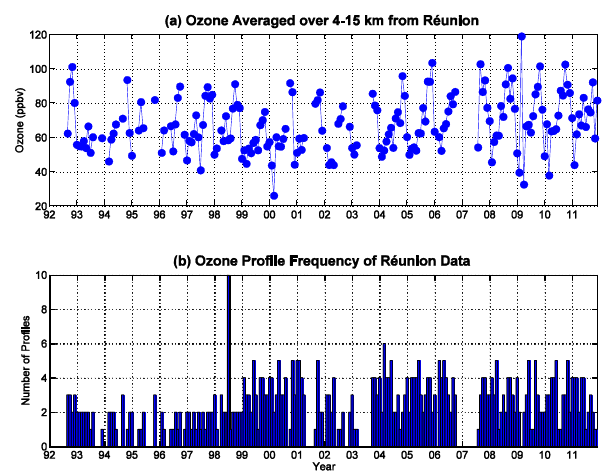
Figure 4. (a) Launch times for Irene, South Africa (25.9 ◦ S, 28.2 ◦ E), balloon-borne ozonesonde–radiosonde packages during 1990–1993 (blue) and for SHADOZ from 1999 to early 2007 (green). (b) Mean ozone mixing ratio in the 1.5–4km layer from Irene sondes corresponding to the sampling times in (a) , showing the upward trend in ozone mixing ratio as launch times moved later in the day. (c) Correlation between sonde launch times and ozone mixing ratio from the time series in ( a ) and ( b ) as a function of altitude in 0.1km bins from the surface (1.5km) to